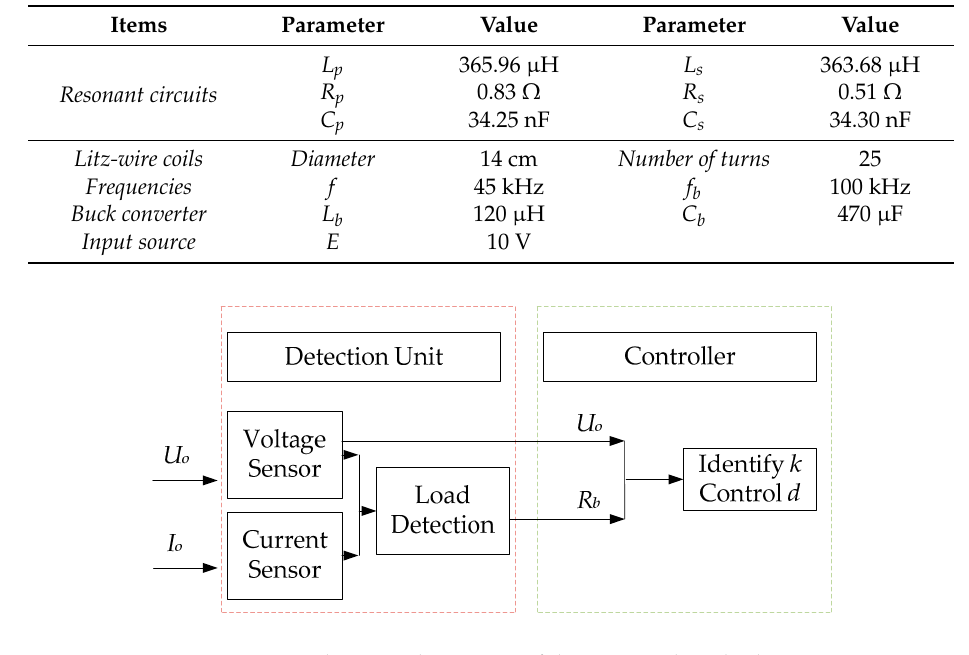
Figure 6. The control structure of the proposed method.